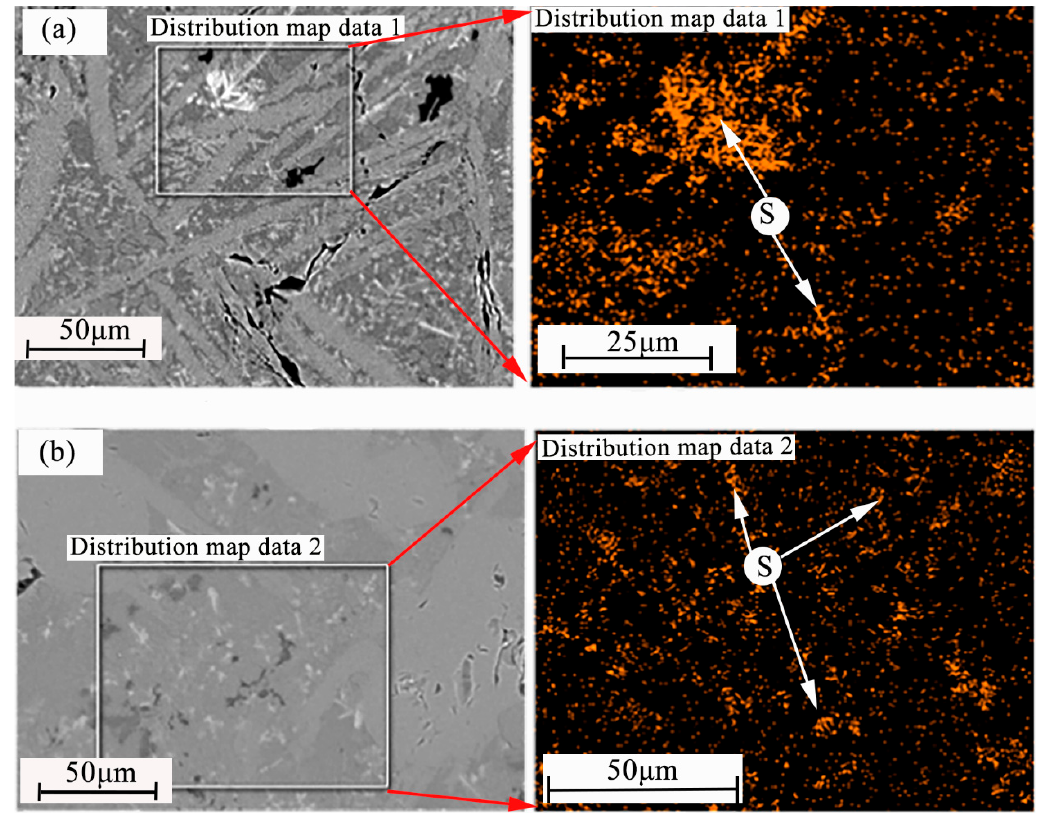
Figure 8. Surface scanning analysis of the sulfur elements in molten slag. ( a ) S1 with a basicity of 2.5, ( b ) S3 with a basicity of 3.5.